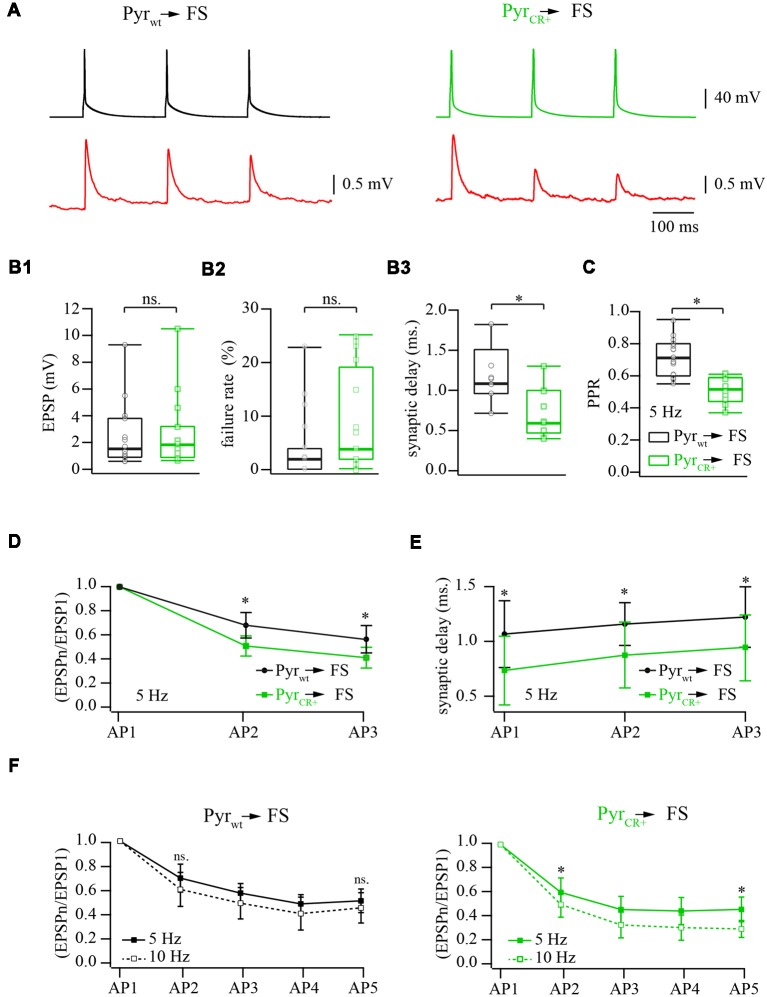
Effect of calretinin expression in pyramidal cells, on the characteristics of layer 2/3 pyramidal neuron to fast-spiking (FS) interneuron synapses. (A) Representative averaged traces of presynaptic APs and postsynaptic EPSPs recorded from connected pairs of layer 2/3 pyramidal and FS neurons. Recordings obtained from WT neurons are shown on the left panel, the data from the pairs where presynaptic pyramidal cell was expressing calretinin are on the right. (B) Box plots show the effect of the calretinin expression (green box) on the basic release properties (B1: EPSP amplitudes; B2: failure rate; B3: synaptic delay) in comparison to the WT data (black box). Open symbols represent the averaged value obtained in individual experiments. (C) Presynaptic calretinin expression reduces paired-pulse ratio (PPR) at layer 2/3 pyramidal to FS cell synapses (green box) relative to WT buffer-free synapses (black box). Open symbols represent the averaged value obtained in individual experiments. (D) Comparison of PPR for the second and the third responses in WT (calretinin-free; black) and calretinin-expressing (green) synapses. Data are shown as mean ± SD. (E) Reduction of synaptic delay remains significant for the second and the third responses in WT (calretinin-free; black) and calretinin-expressing (green) synapses. Data are shown as mean ± SD. (F) Differential effect of simulation frequency enhancement (from 5 to 10 Hz) on “immediate” (EPSP2/EPSP1) and steady-state depression (EPSPn/EPSP1) at WT (left panel) and calretinin-expressing synapses (right). Data are shown as mean ± SD. Significant difference is marked as (*), ns, non-significant.